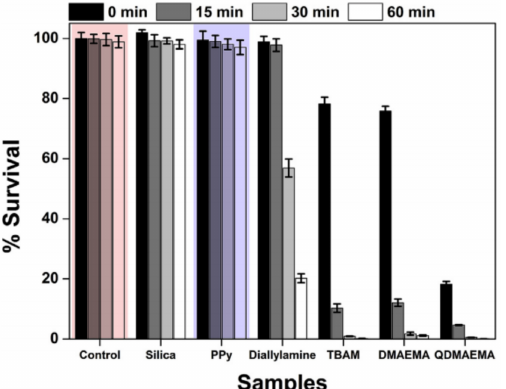
Figure 13. Graphical representation of the relative survival rate of the different NPs functionalized with different quaternary amines. Retrieved from